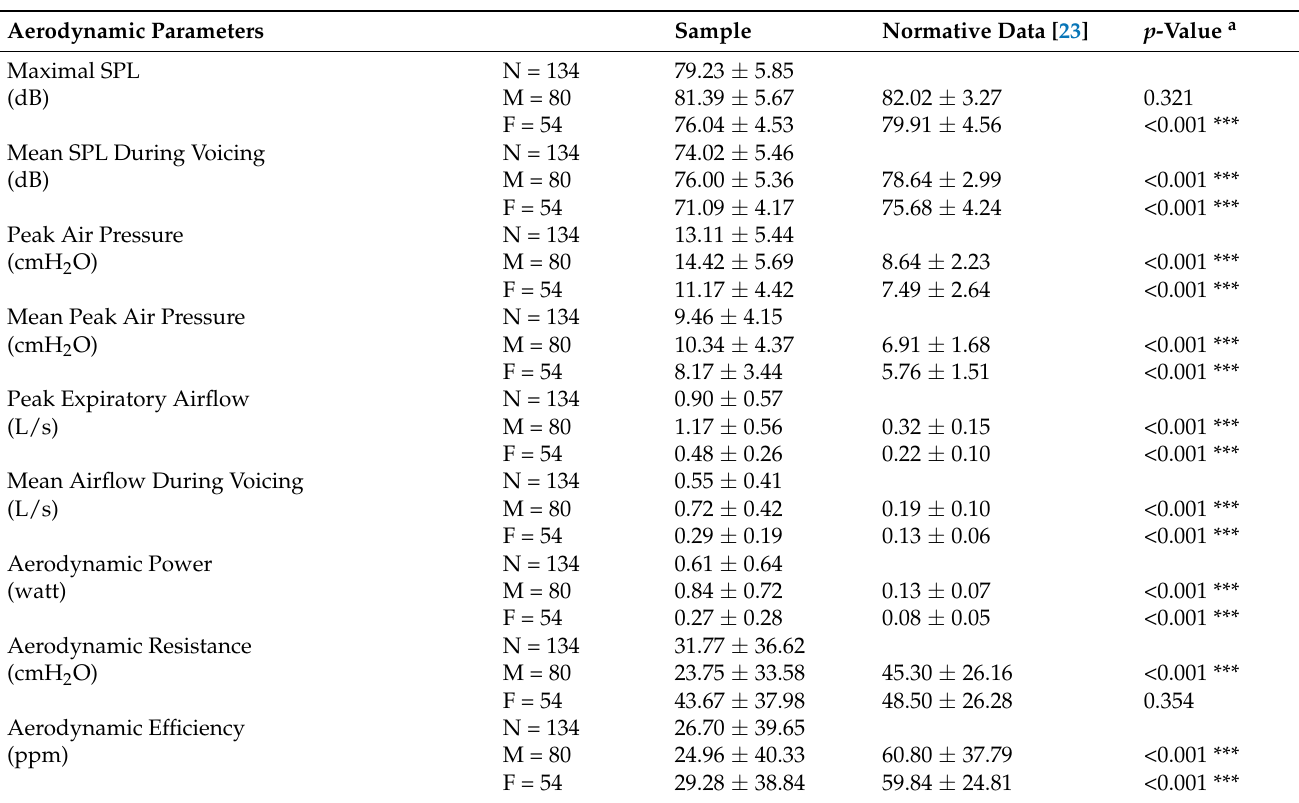
Table 2. Comparison of aerodynamic parameters with the normative data for the age-and gender- matched subjects.